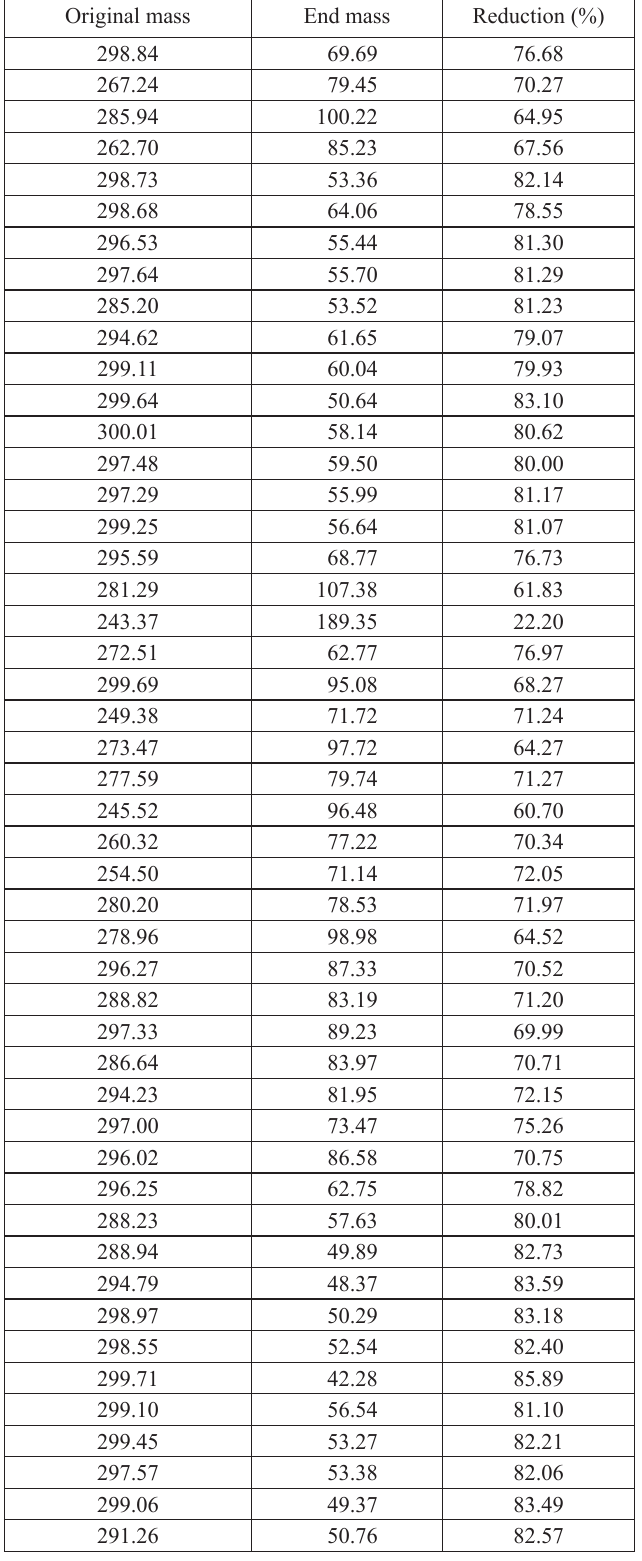
Table 1. Results from screenwashing using paint sieves. Matrix was collected from the Two Sisters 2 Quarry located in the lower part of the Morrison Formation, Upper Jurassic, in northern Wyoming, USA. All measurements are in